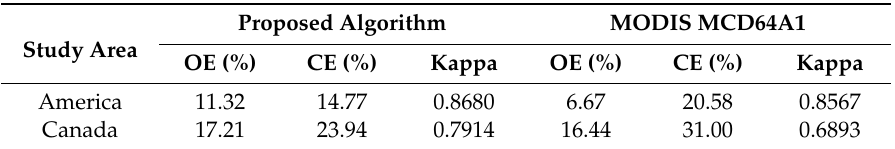
Table 2. Comparison of the accuracy of the proposed algorithm and MODIS MCD64A1 for the two study